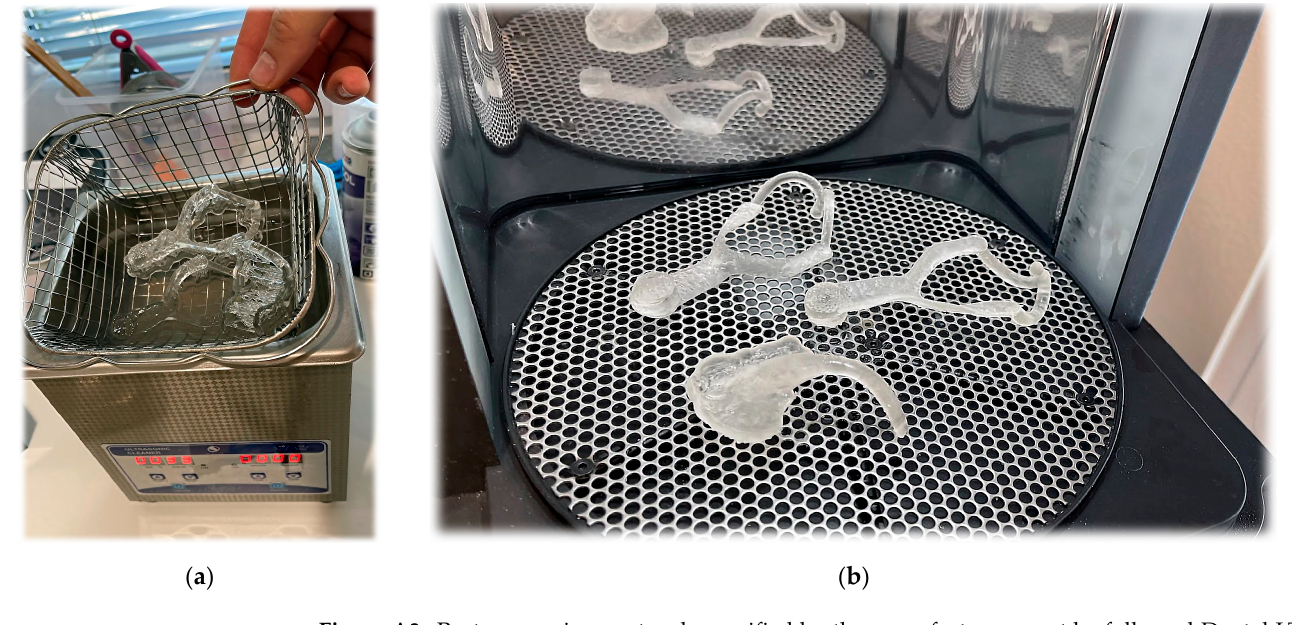
Figure A3. Post-processing protocols specified by the manufacturer must be followed Dental LT Clear V2: ( a ) rinsing was performed for 20 min in a 99% IPA isopropanol ultra- sonic bath, air drying for 30 min and 20 min; ( b ) UV-curing performed for 60 min at 60 °C (FormCure, Formlabs).